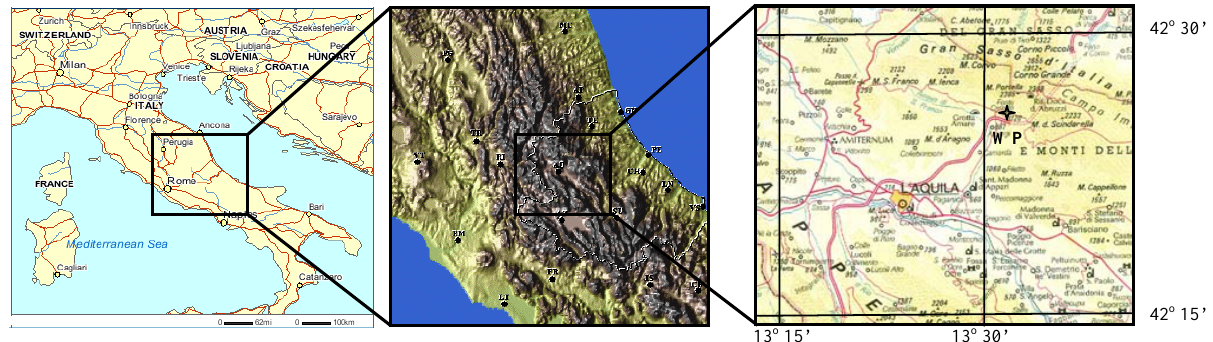
Fig. 1. Map of the Assergi site. The altitude of the region in the right panel ranges between 700 and 2912m ASL. In the right panel the wind profiler (WP) location is denoted with the